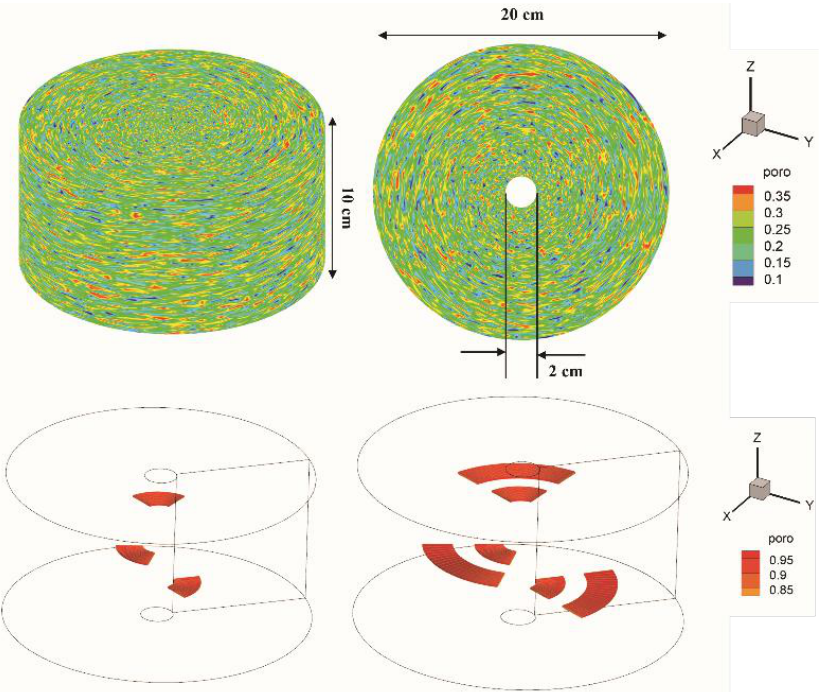
Figure 9. The dimension of the core sample, initial porosity profile, and randomly distributed fractures.